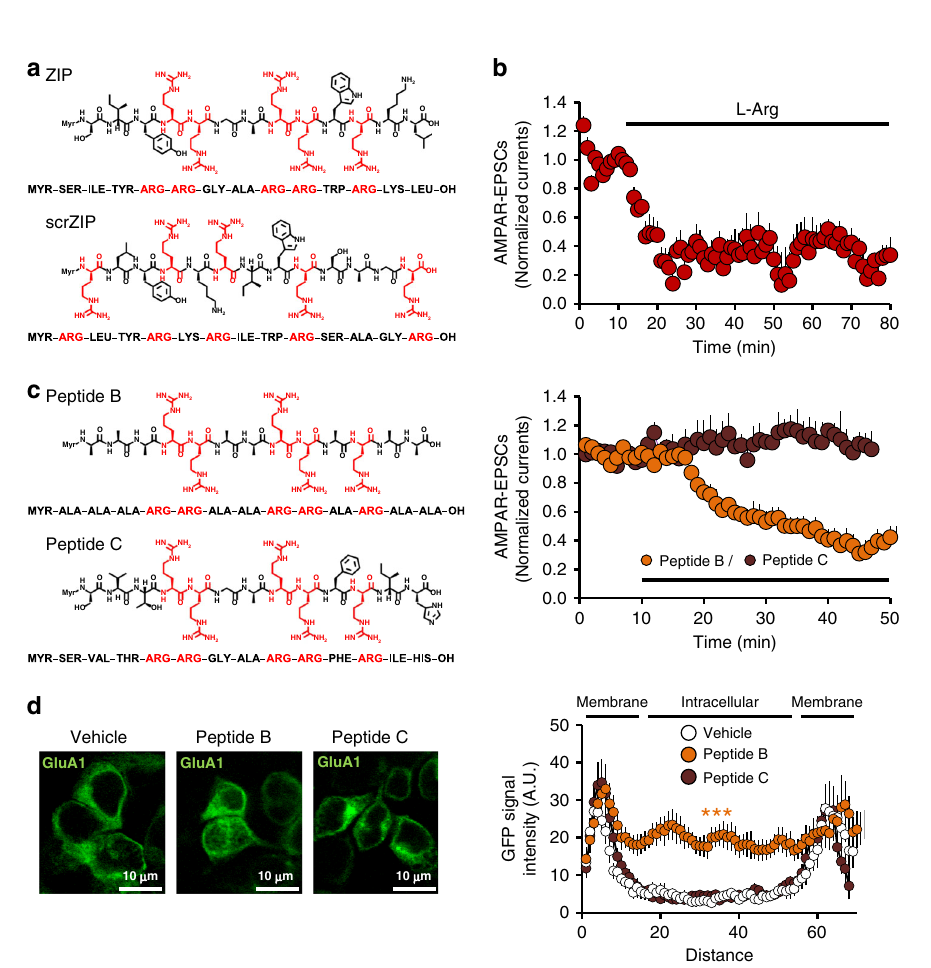
Fig. 2 ZIP mediates its effects on recombinant and native AMPARs by serving as an arginine donor. a Peptide structures of ZIP and scr-ZIP. Arginine residues are marked in red. scrZIP contains the ZIP amino acids in a random order. b AMPAR-EPSCs, recorded before and after bath application of L-Arg (5 μ M, N = 4, n = 4). Data presented using normalized values ± SEM. c Peptide B but not peptide C mimics ZIP effects. Peptide B contains the fi ve arginine residues of ZIP, replacing the eight other amino acids with alanine. Peptide C also contains fi ve arginine residues but lacks its peptidase-cleavage sites due to appropriate replacements (see structures and sequences). Right, AMPAR-EPSCs recorded before and after application of peptide B ( N = 3, n = 4) or peptide C ( N = 3, n = 3). Data presented using normalized values ± SEM. d Representative fl uorescent images of fi xed GFP-GluA1-expressing HEK293 cells, incubated for 40 min prior to the fi xation with one of the peptides or vehicle. Graph depicts line scan of GFP signal intensity mean ± SEM (vehicle n = 7, Peptide B n = 10, Peptide C n = 9; F = 23.85, p < 0.0001, one-way ANOVA, followed by Tukey post hoc test for multiple comparisons, Peptide B vs. vehicle *** p < 0.0001, Peptide B vs. Peptide C *** p <